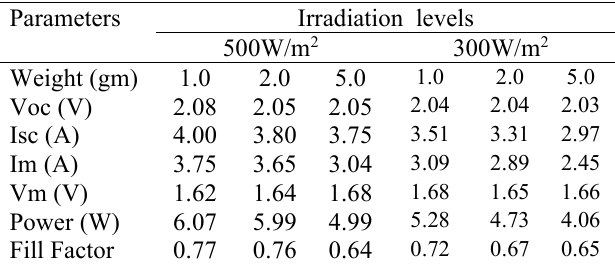
Table 4. Comparison of parameter with sugar mill Bagasse dust at 500/300 W/m 2